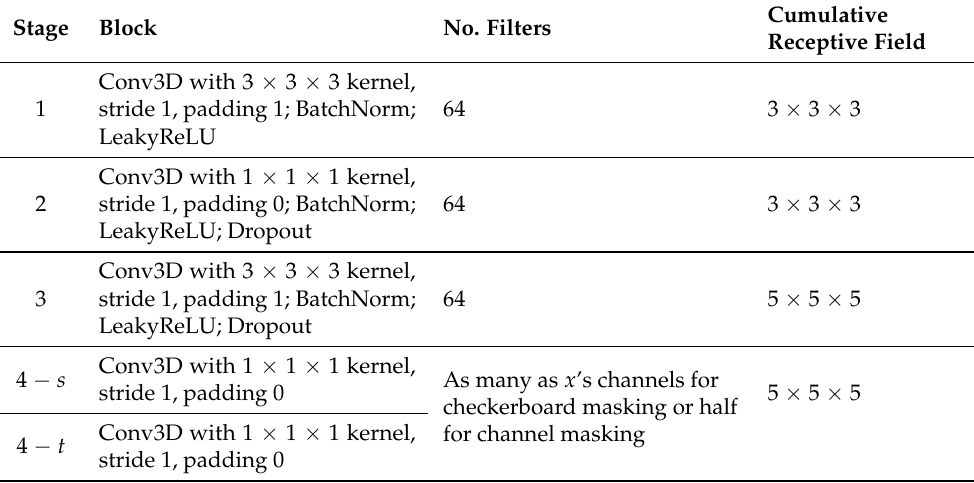
Table 2. s and t network